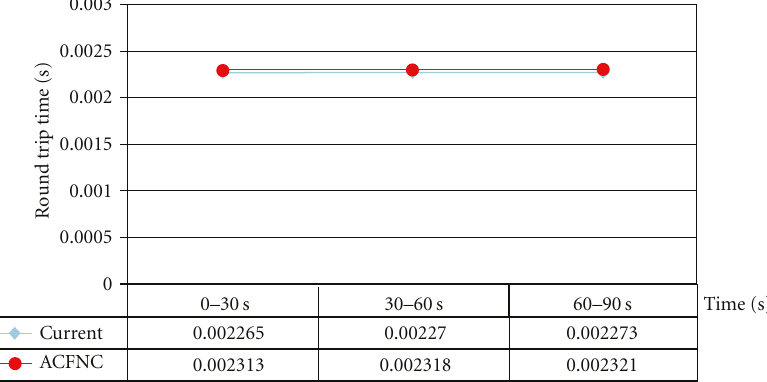
Figure 11: RTT comparison in baseline